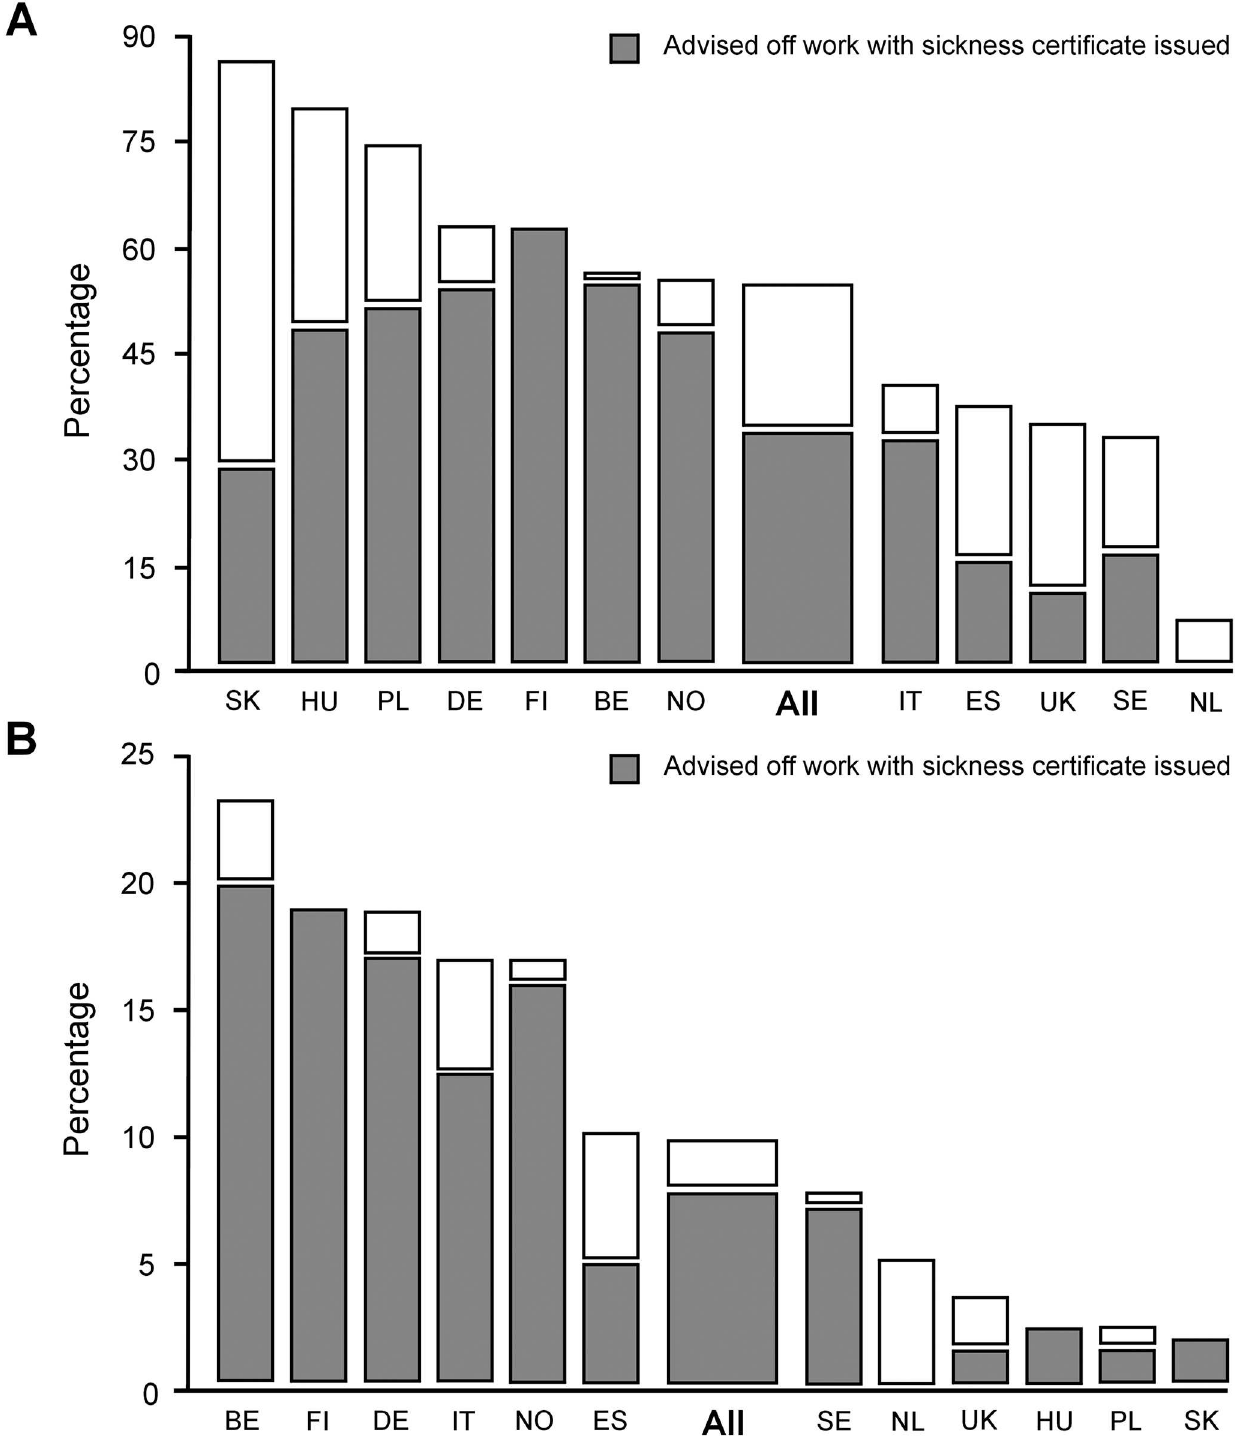
Fig 1. FPs’ advice to take time off work for LRTI. Panel A: FP’s advice to take time off work for LRTI by network—data presented as percentageof the employedpopulation(full or part time) of those advised to take time off work by their FPs. Panel B: Proportion of employed patients reportingsickness certificationas major reason for consulting their FPs by network—data presented as percentageof patients who indicatedthat sick certificationwas the main reason for consulting their FPs in relation to the group of working population.Insert grey bars represent the proportion of patients who received a formal sickness